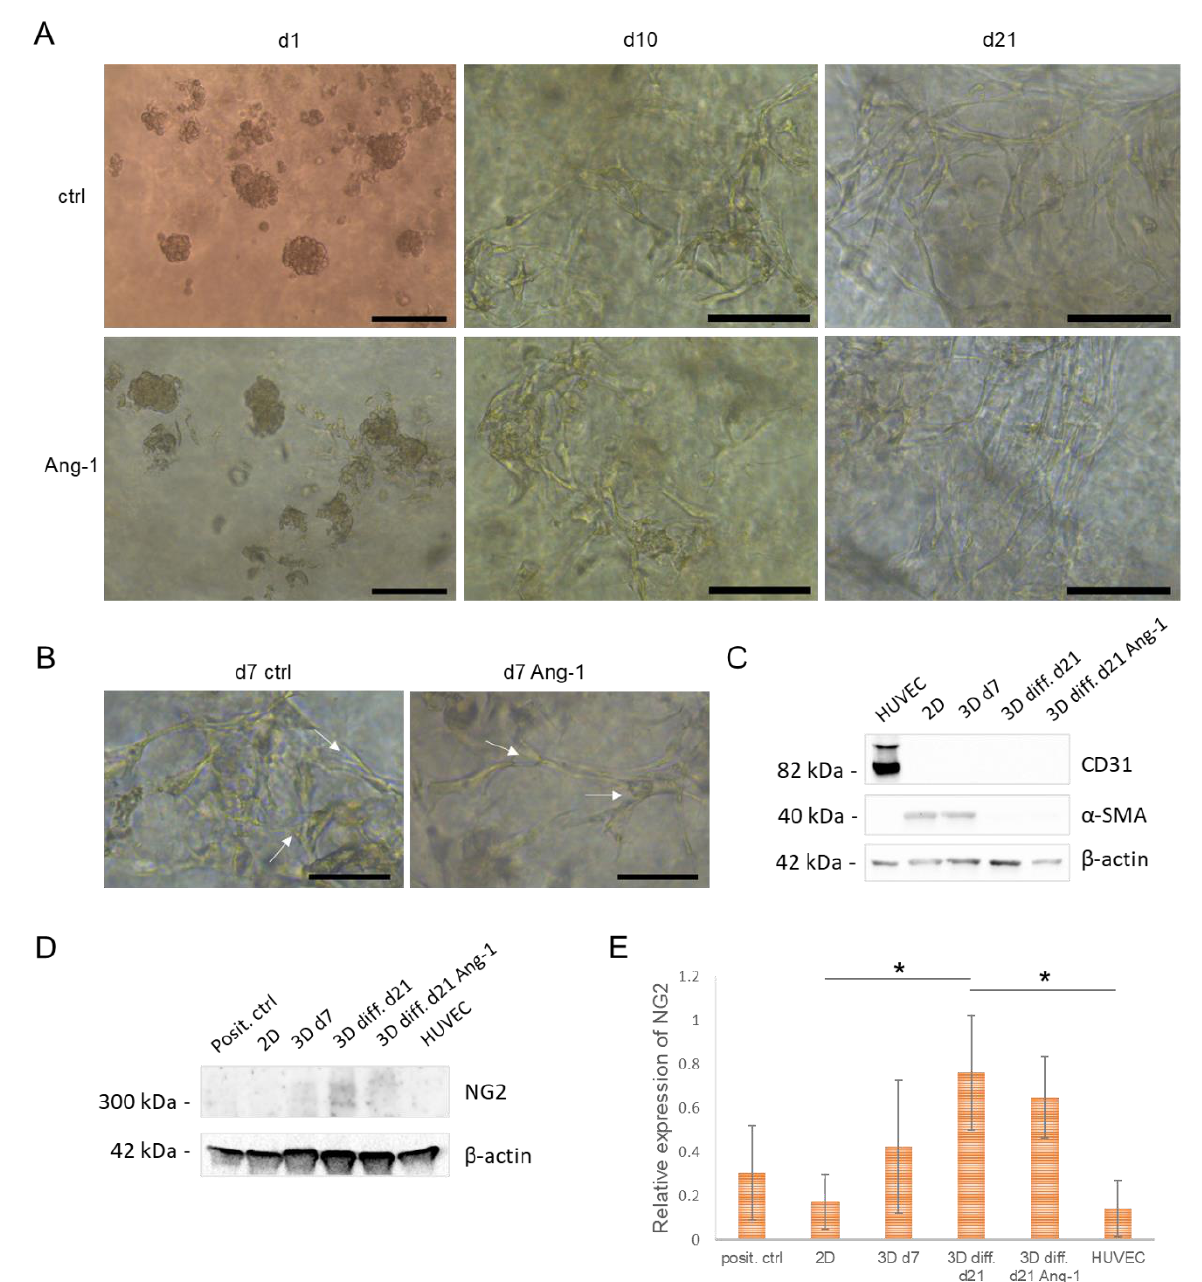
Figure 4. Differentiation of hASCs towards endothelial cells (ECs) in NFC hydrogel. ( A ) Differentiation of hASCs in 0.125% NFC hydrogel in endothelial growth medium for 21 days. Scale bars, 100 µ m (d1) and 50 µ m (d10, d21). ( B ) Differentiated cells in 0.125% NFC hydrogel on d7 showing branching of cellular structures (arrows). Scale bars, 25 µ m. ( C ) Western blot showing expression of endothelial specific marker CD31 and alpha-smooth muscle actin ( α -SMA) in hASCs vs. human umbilical vein endothelial cells (HUVEC) ( n = 3, 1 technical replicate). ( D ) Western blot of pericyte marker NG2 in hASCs and HUVECs. ( E ) Quantification of NG2 expression ( n = 3, 1 technical replicate). * p < 0.05. Ang-1, angiopoietin-1; diff., differentiated cells.